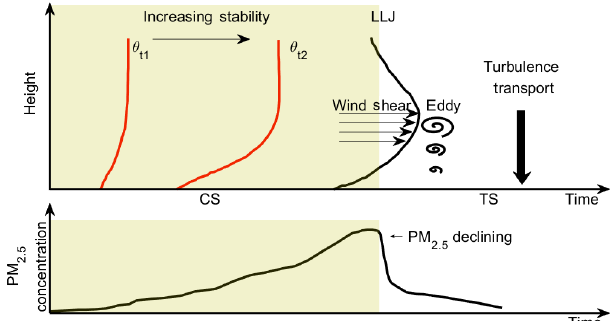
Figure 11. Schematic of how intermittent turbulence affects the dis- sipation of PM 2 . 5 near the